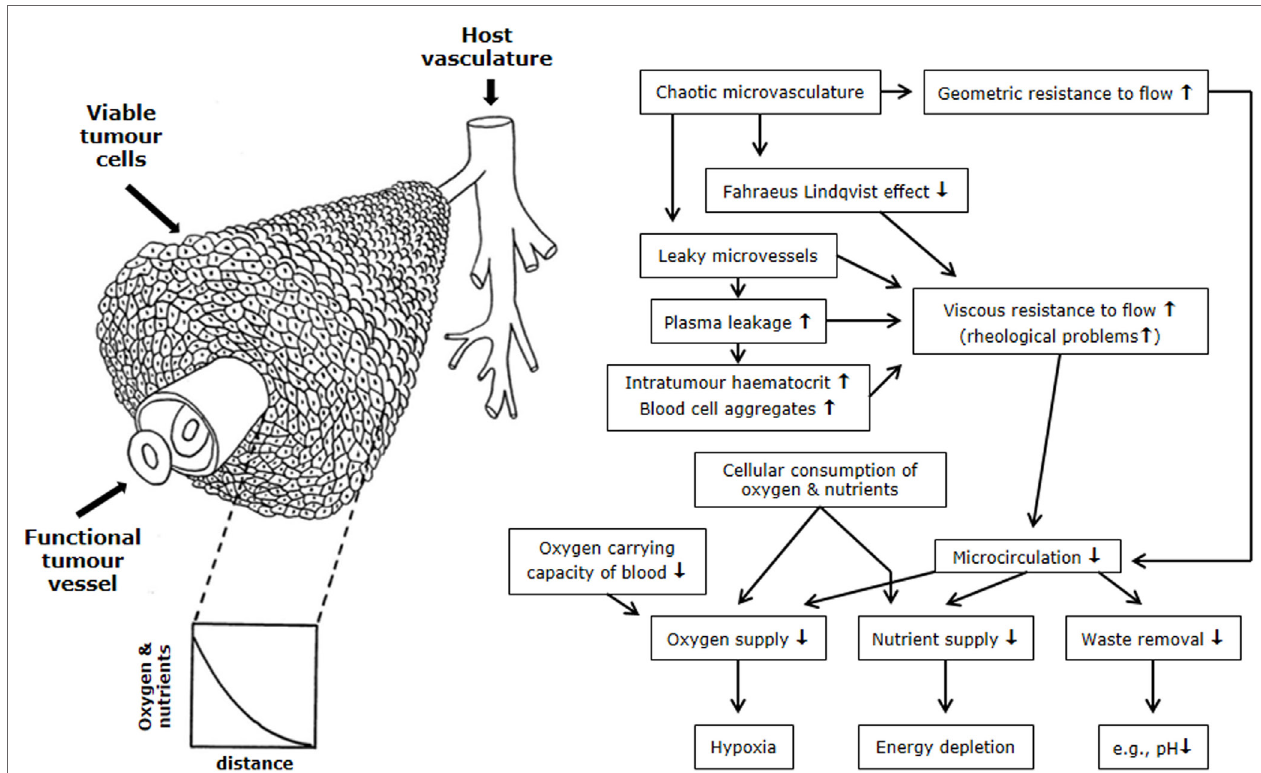
FiGURe 2 | Schematic illustration of the relationship between the tumor vasculature and microenvironment . The left side shows tumor cells growing in a corded structure around a functional vessel from which the cells receive their oxygen and nutrient supply, but as these substances diffuse out from the vessel they are utilized by the cells so that gradients are established. On the right side is a flow chart showing the relationship between the hostile microenvironment of tumors and the factors that give rise to its development. Figure is modified from Ref. (1,